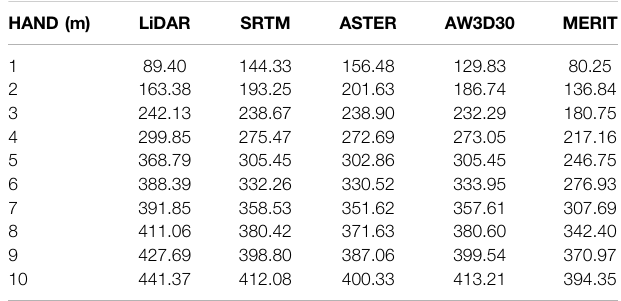
TABLE 3| Flood extentsderivedfromeach DEMforeach 1-m fl ooddepthinterval in square kilometers. HAND